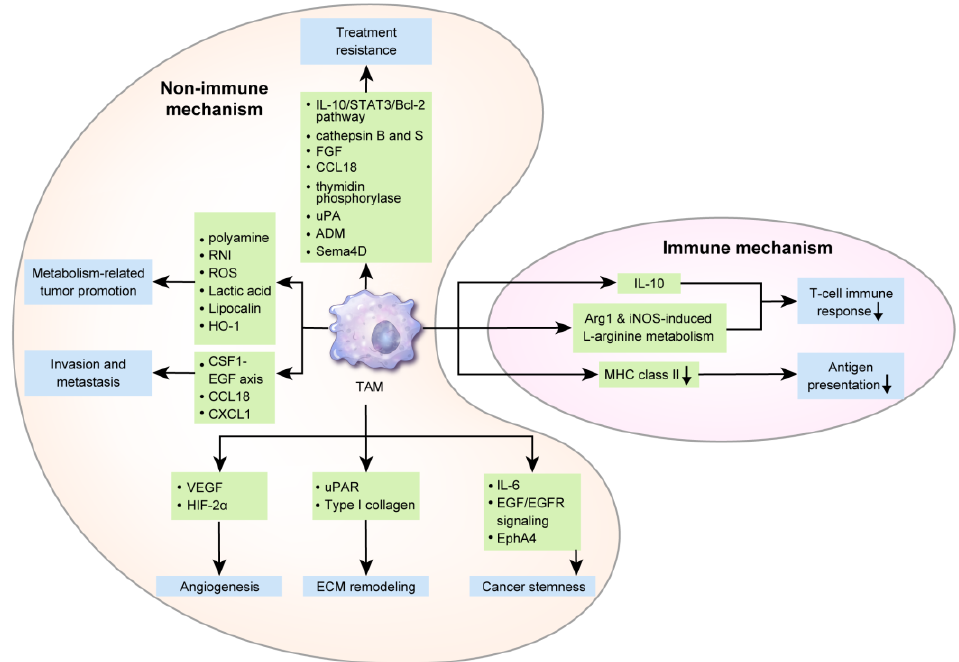
Figure 2. The role of tumor-associated macrophages (TAMs) in breast cancer: One of the immunogenic mechanisms underlying the secretion of IL-10, Arg1, and iNOS-related L-arginine by TAMs in breast cancer, which suppress the T-cell response and antigen presentation by decreasing major histocompatibility complex (MHC) class II levels. Non-immunogenic mechanisms include angiogenesis via the secretion of VEGF and hypoxia-inducible factor (HIF)-2 α ; extracellular matrix remodeling via releasing urokinase receptor (uPAR) and type I collagen; and evoking cancer stemness through IL-6, epidermal growth factor (EGF) / EGF receptor(EGFR) signaling, and EphA4. TAM contributes to invasion and metastasis via the CSF1-EGF axis, CCL18, and CXCL1. Polyamine, reactive